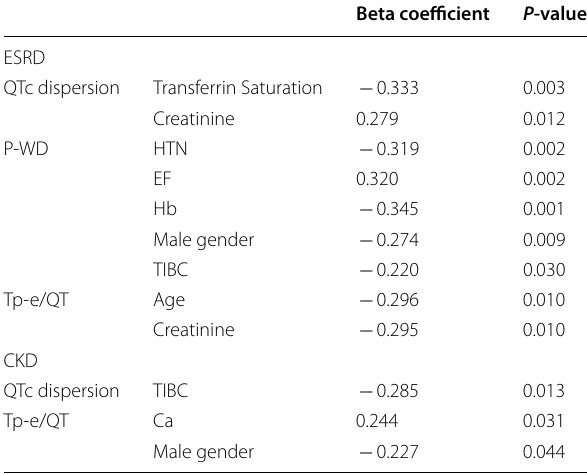
Ca, Calcium; EF, Ejection Fraction; Hb, Hemoglobin; HTN, Hypertension; P-WD, P wave dispersion; QTc, Corrected QT interval; TIBC, Total Iron Binding Capacity; Tp-e, T wave peak to end interval